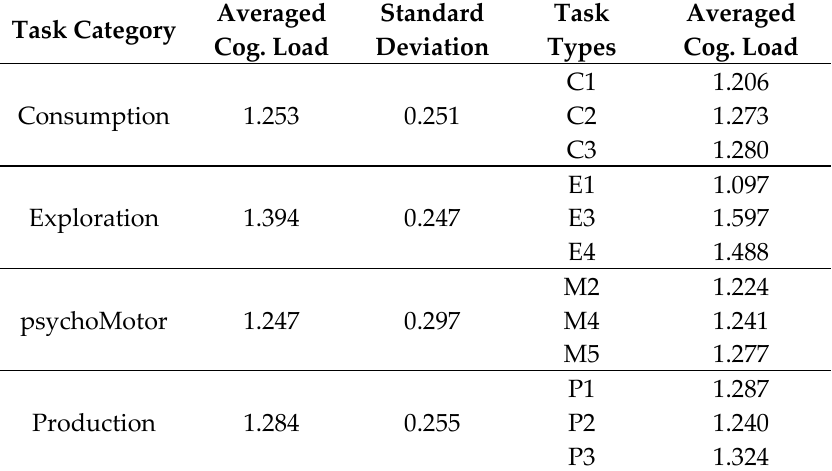
Table 3. Results of cognitive load in each task performed in the experiment according to HuSBIT-10